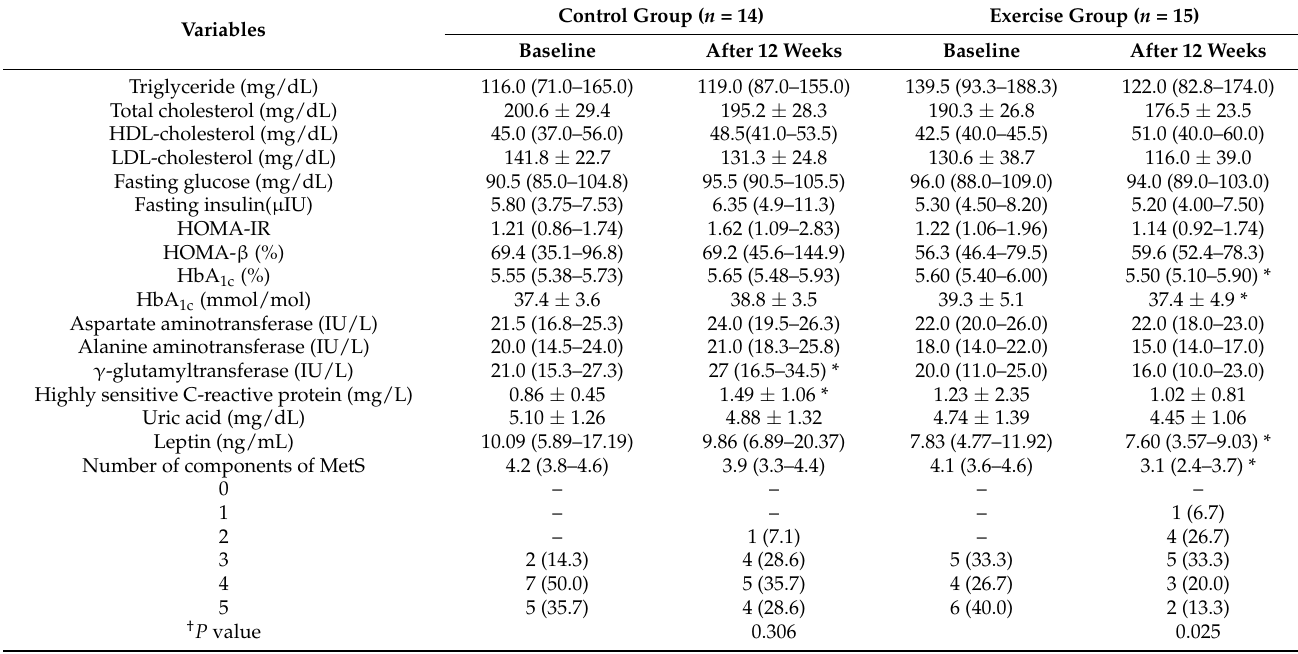
Table 2. Changes in biochemical profiles and the number of metabolic syndrome components from baseline to 12 weeks in control and exercise groups.